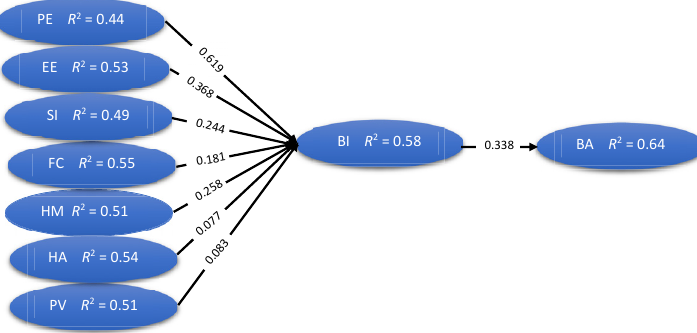
Figure 2. Path coefficients of the study